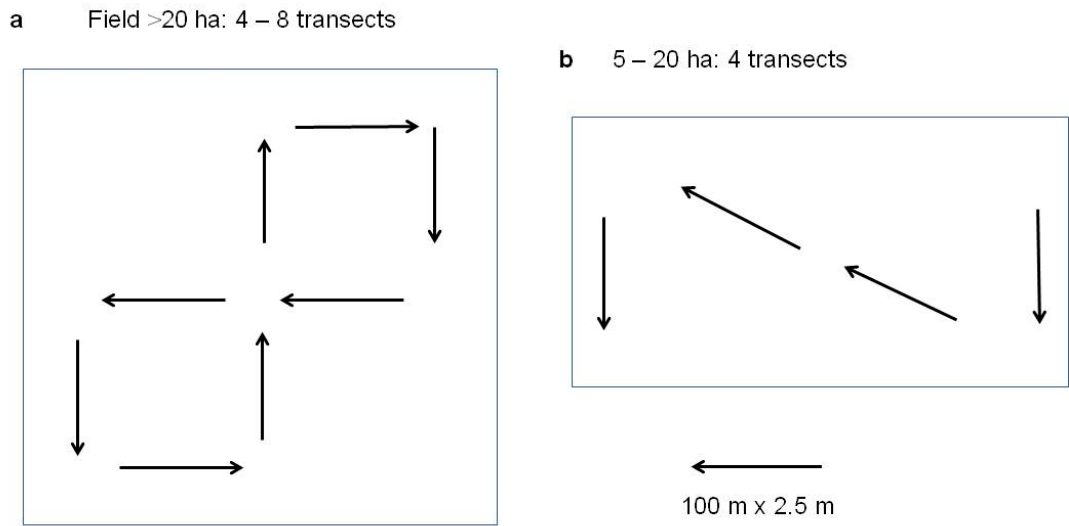
Figure 1. The spatial pattern suggested for situating the sampling transects within the field with sizes ( a ) above and ( b ) below 20 ha [2].